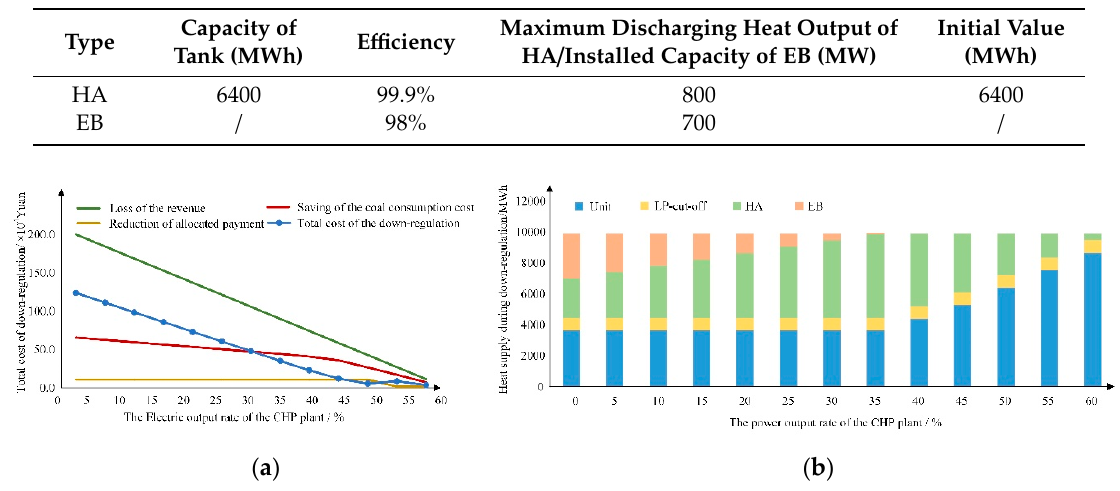
Table 2. Parameters of flexible heating devices.